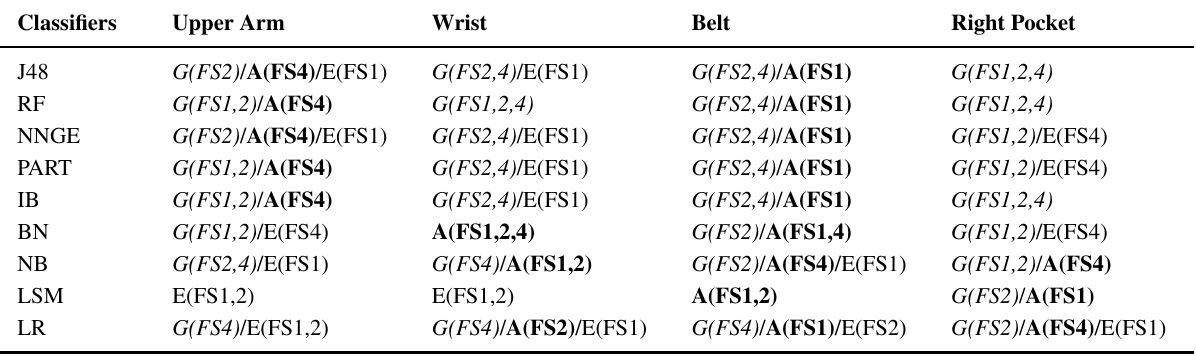
Table 5. Leading role: Accelerometer vs . gyroscope for the walking downstairs activity.